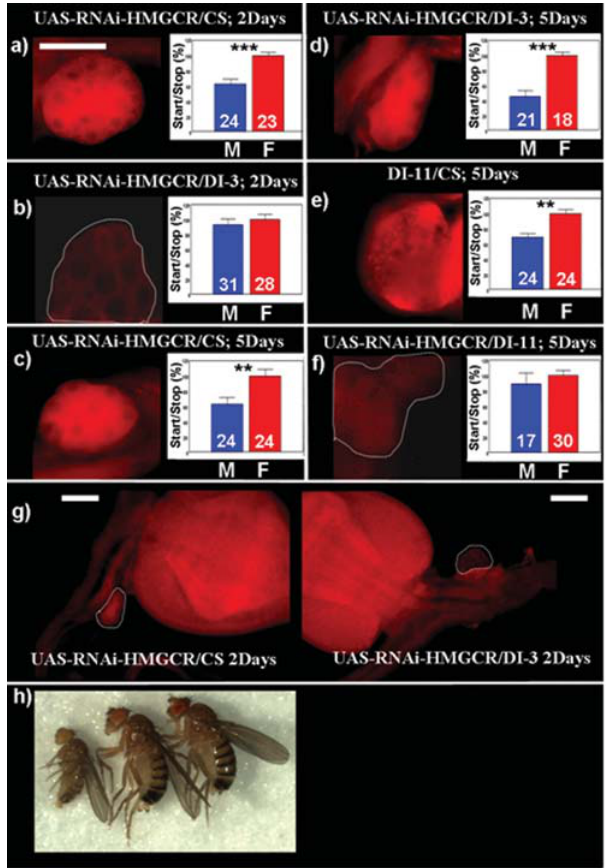
Figure 5. Directed expression of p[UAS-RNAi-HMGCR] specifically in the corpusallatummimics the hmgcrmutation, by disrupting the sexual dimorphism. For all panels (a–g): immunostaining using a primary antibody raised against the human form of the HMGCR, revealed with a secondary antibody labeled with Cy3 (red). a–d) Targeting UAS-RNAi-HMGCR specifically in the ca yields to the lack of the HMGCR protein, and leads to the disruption of the sexual dimorphism. This effect is completely reversible. In 2 days old DI-3/ UAS-RNAi-HMGCR flies (b), HMGCR protein is not detectable and the number of start/stop is identical between males and females compared to controls (a) (2 days old UAS-RNAi-HMGCR/CS flies). Interestingly, in 5 days old flies, both DI-3/UAS-RNAi-HMGCR (d) and UAS-RNAi-HMGCR/ CS (c) the HMGCR is detectable and the start/stop number is sexually dimorphic. This is in agreement with the temporal expression pattern driven by the DI-3. Additionally, this result strongly suggests the reversibility of the RNAi effect. N.B: results from b) and d) come from the same flies, recorded at 2 and 5 days old respectively. e, f) Expressing the UAS-RNAi-HMGCR in the ca using the DI-11 line (DI-11/UAS-RNAi- HMGCR) also leads to the lack of the HMGCR product (f) and disrupts the sexual dimorphism compared to controls flies (e). g) The HMGCR is expressed both in the c ardia and the ca (left panel) in control flies (2 days old UAS-RNAi-HMGCR/CS flies), whereas in 2 days old (DI-3/ UAS-RNAi-HMGCR) flies, the HMGCR is detected only in the cardia (right panel). This last staining serves as a positive control, to demonstrate that the DI-3 drives the UAS-RNAi-HMGCR only in the ca . h) Expressing the UAS-RNAi-HMGCR in the ca under the control of DI-11 leads to a strong lethality when flies are reared at 24 u C. Moreover, the only few females that survived are dwarf (left: dwarf female DI-11/UAS-RNAi- HMGCR, middle: female control UAS-RNAi-HMGCR/CS] and right: female CS). Scale bar=25 m